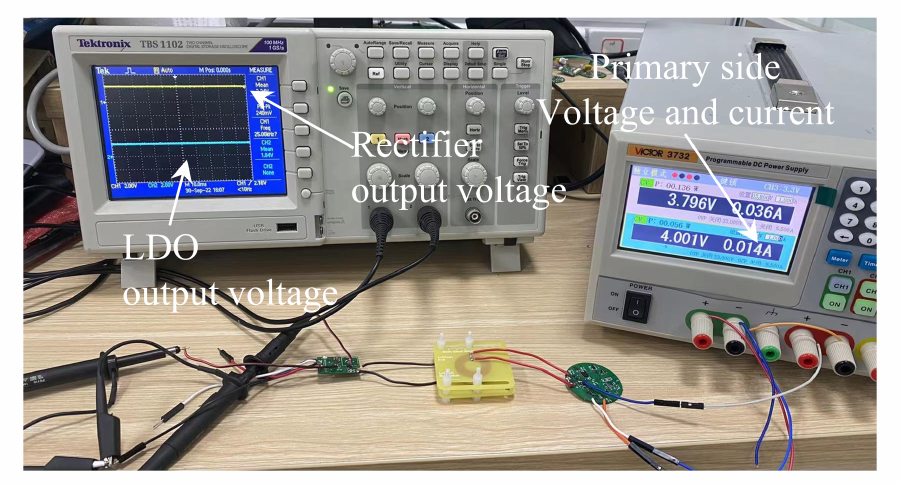
Figure 7. Measurement setup for the linear-power-regulated wireless power transfer system.